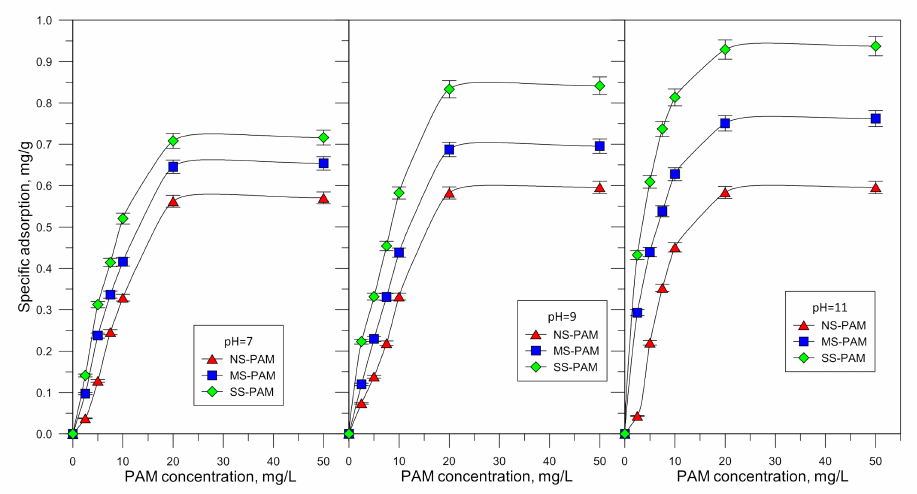
Figure 7. Adsorption isotherms of NS–PAM, MS–PAM, and SS–PAM on molybdenite at di ff erent values of